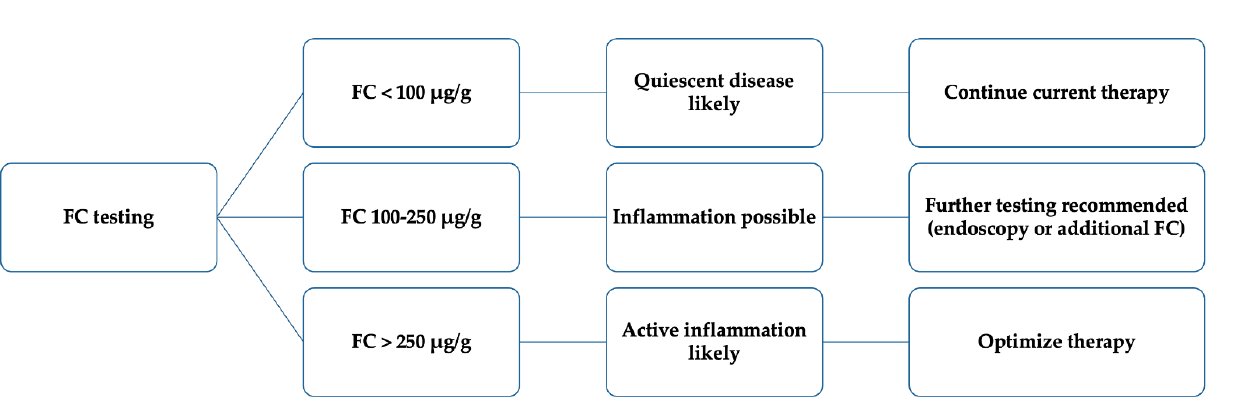
Figure 1. Interpreting fecal calprotectin (FC) testing; modified from Bressler et al. [59].